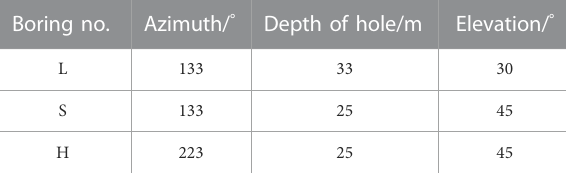
TABLE 3 Design parameters of drilling. Boring